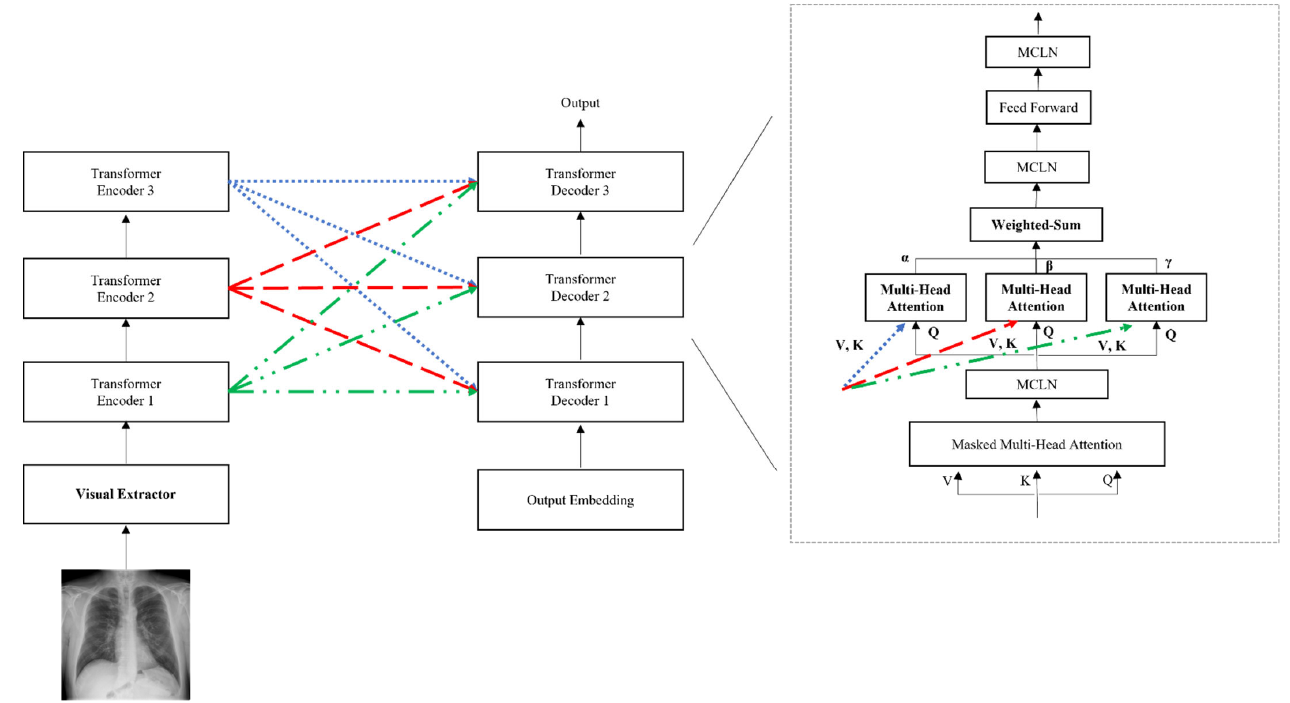
Figure 4. The proposed CEDT model architecture. The outputs of each encoder are used in the de ‐ coders.